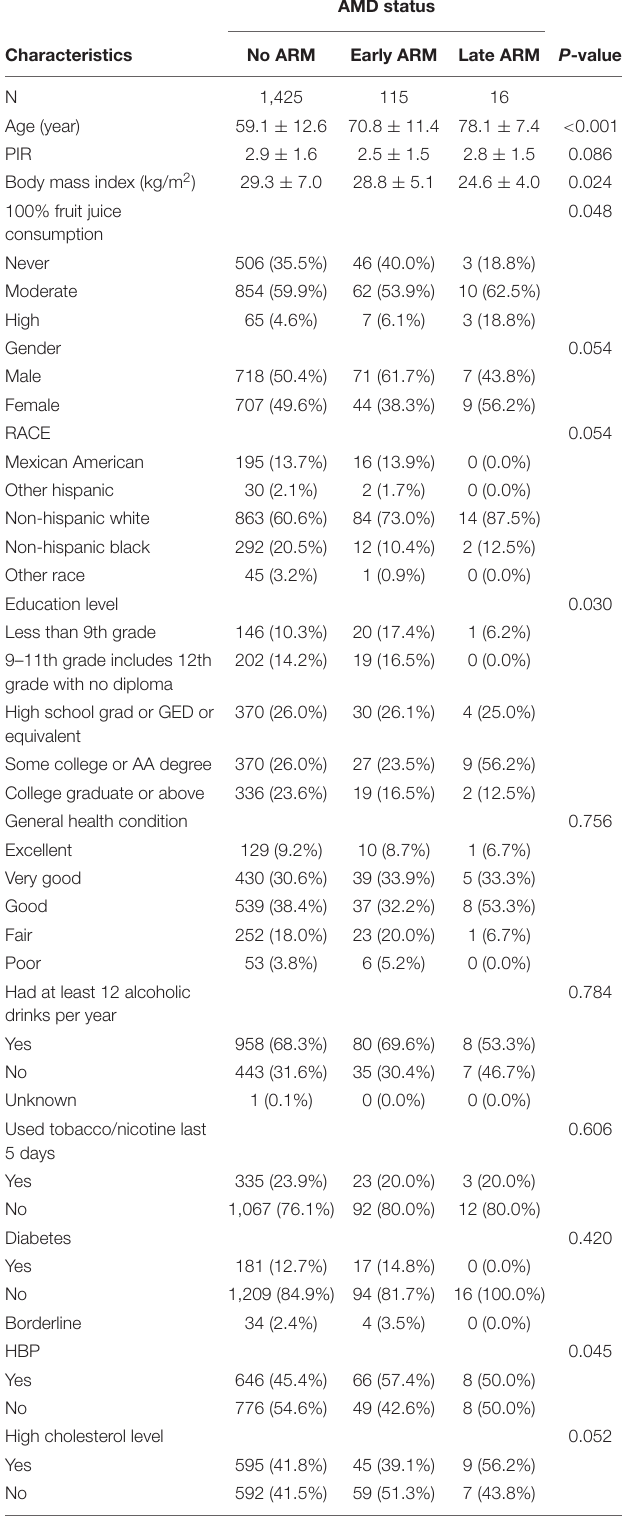
TABLE 1 | Socio-demographic and clinical characteristics of participants by age-related macular degeneration (AMD)